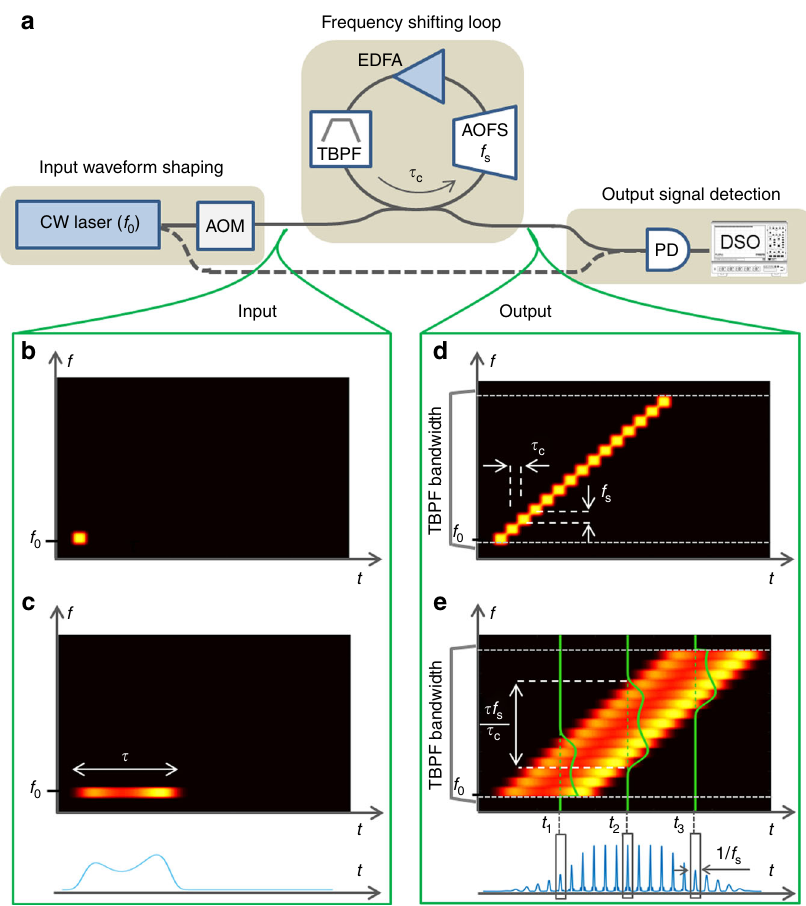
Fig. 1 Principle of arbitrary optical fi eld spectrum synthesis and control. a experimental setup. The input waveform shaping unit comprises a seed CW laser (frequency: f 0 ) and an acousto-optic modulator (AOM). The FSL (travel time: τ c ) comprises an acousto-optic frequency shifter (AOFS) driven at f s , a tunable bandpass fi lter (TBPF), and an optical ampli fi er (EDFA). The output signal is detected by a fast photodetector (PD) and numerically processed with a fast digital sampling oscilloscope (DSO). A fraction of the CW seed laser can be used as a reference, for heterodyning with the optical output of the FSL (dashed line). An optional time-gating device can be inserted to extract an individual waveform from the output train. b – e intuitive explanation of the technique in the time-frequency plane, with a short ( b , d : duration ~ τ c ) and a long ( c , e duration τ > τ c ) injection signal. The signal at the FSL output